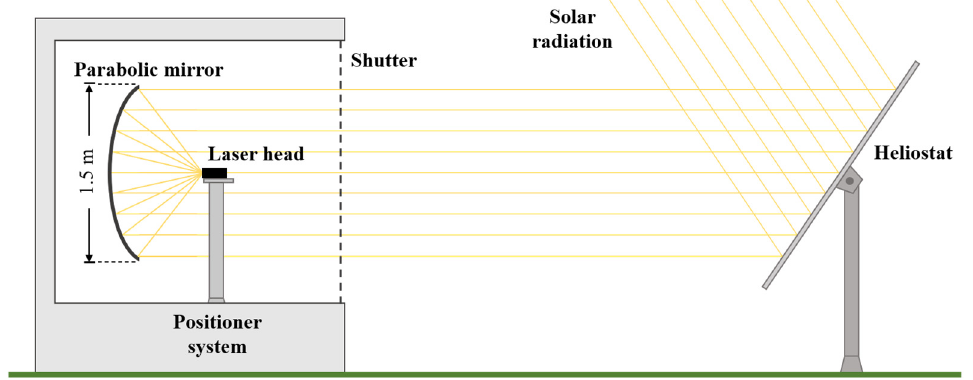
Figure 2. Schematic of the NOVA heliostat–parabolic mirror system.